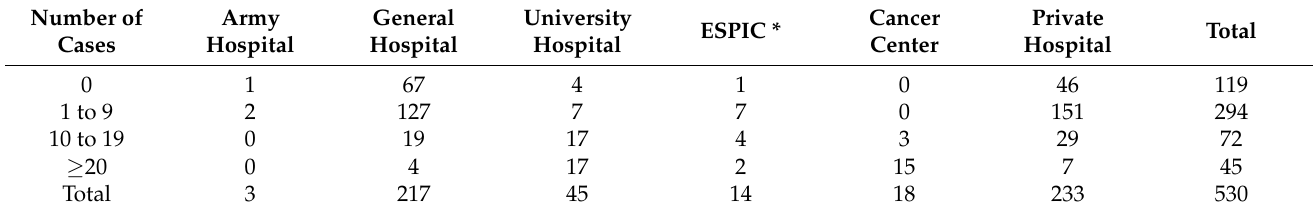
Table 3. Institutions who have treated at least one ovarian cancer in 2018.